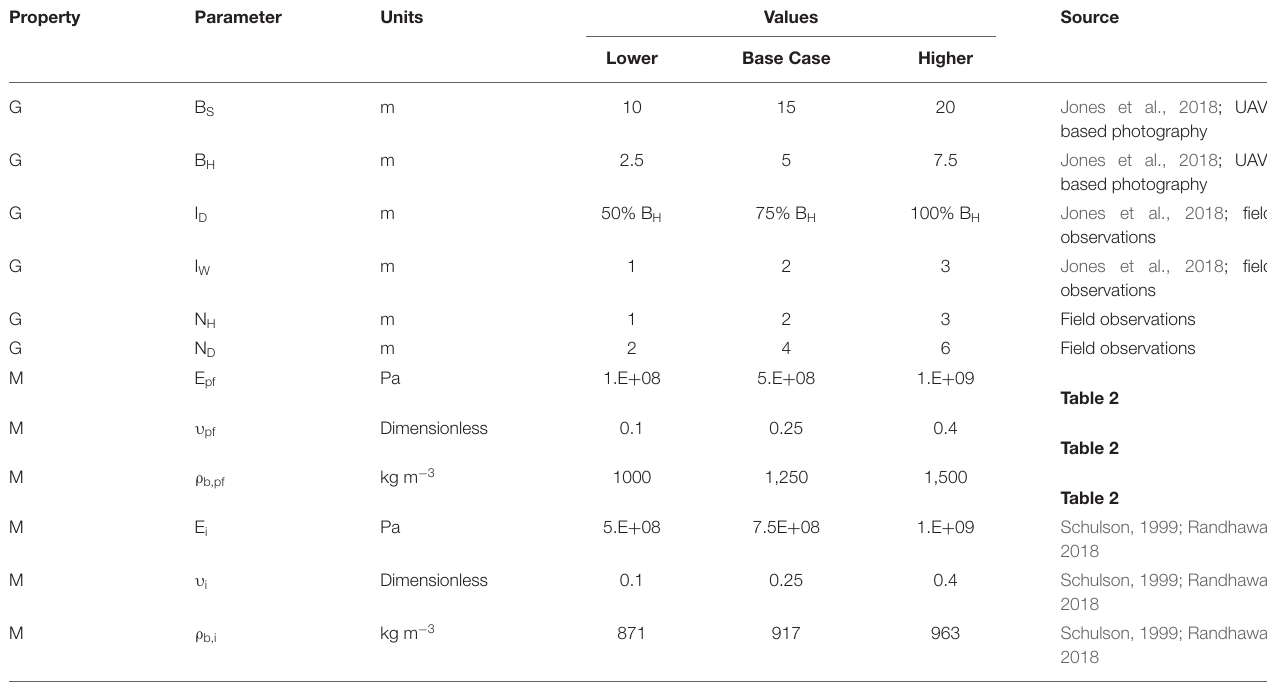
TABLE 1 | Parameter values used to evaluate the impact of variability in geometric and material properties on the magnitude and location of the simulated maximum tensile stress. Property